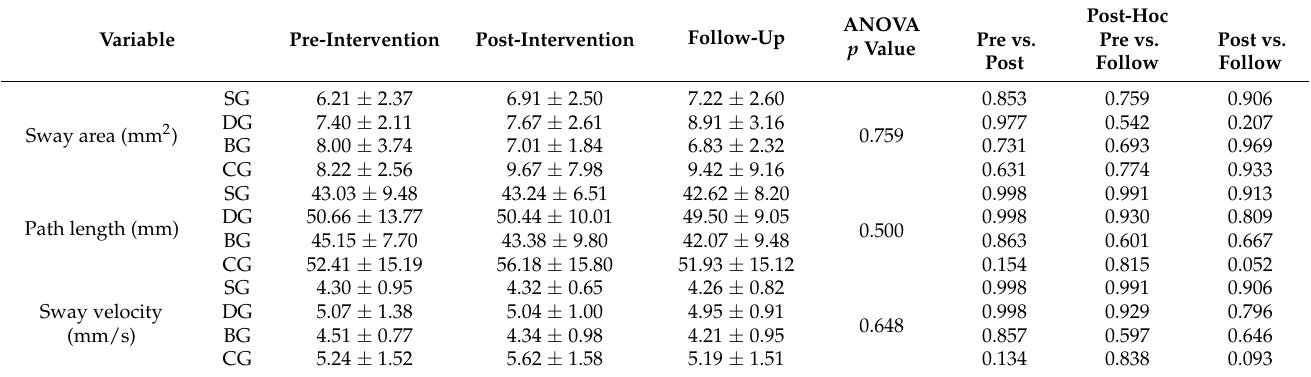
Table 2. Static balance ability in the eyes-open condition.